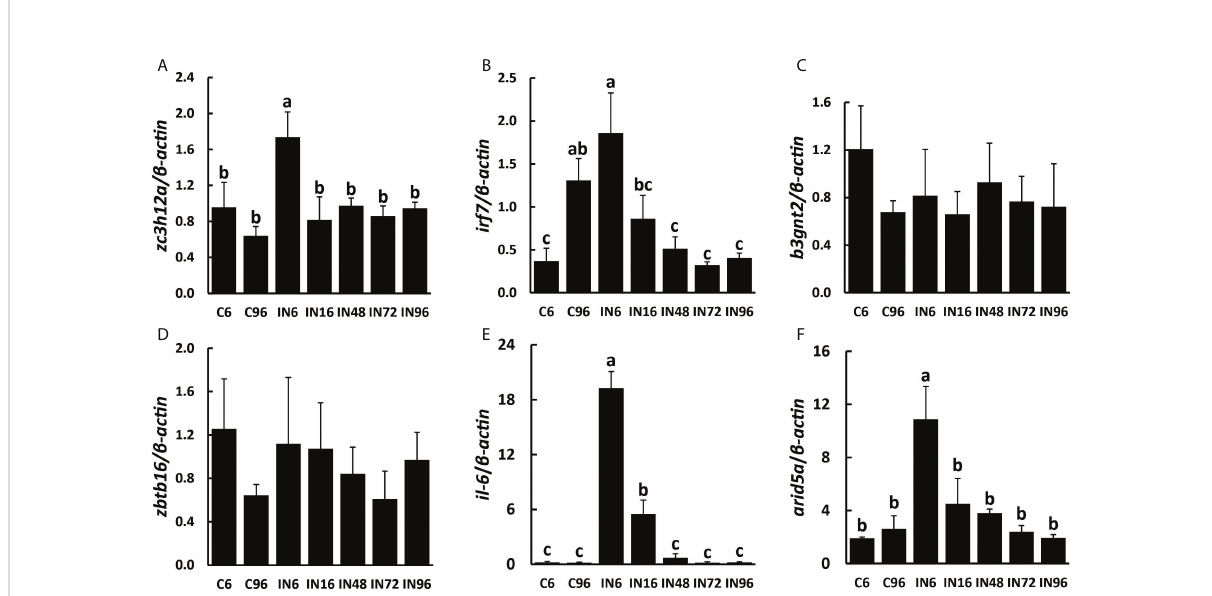
FIGURE 6 Expressions of target genes involved in in fl ammatory and immune responses in spleen. The expressions of zc3h12a (A) , irf7 (B) , b3gnt2 (C) , zbtb16 (D), il-6 (E) and arid5a (F) in spleen. a,b,c Mean values with unlike letters were signi fi cantly different ( P < 0.05, One-way analysis of variance, Tukey ’ s